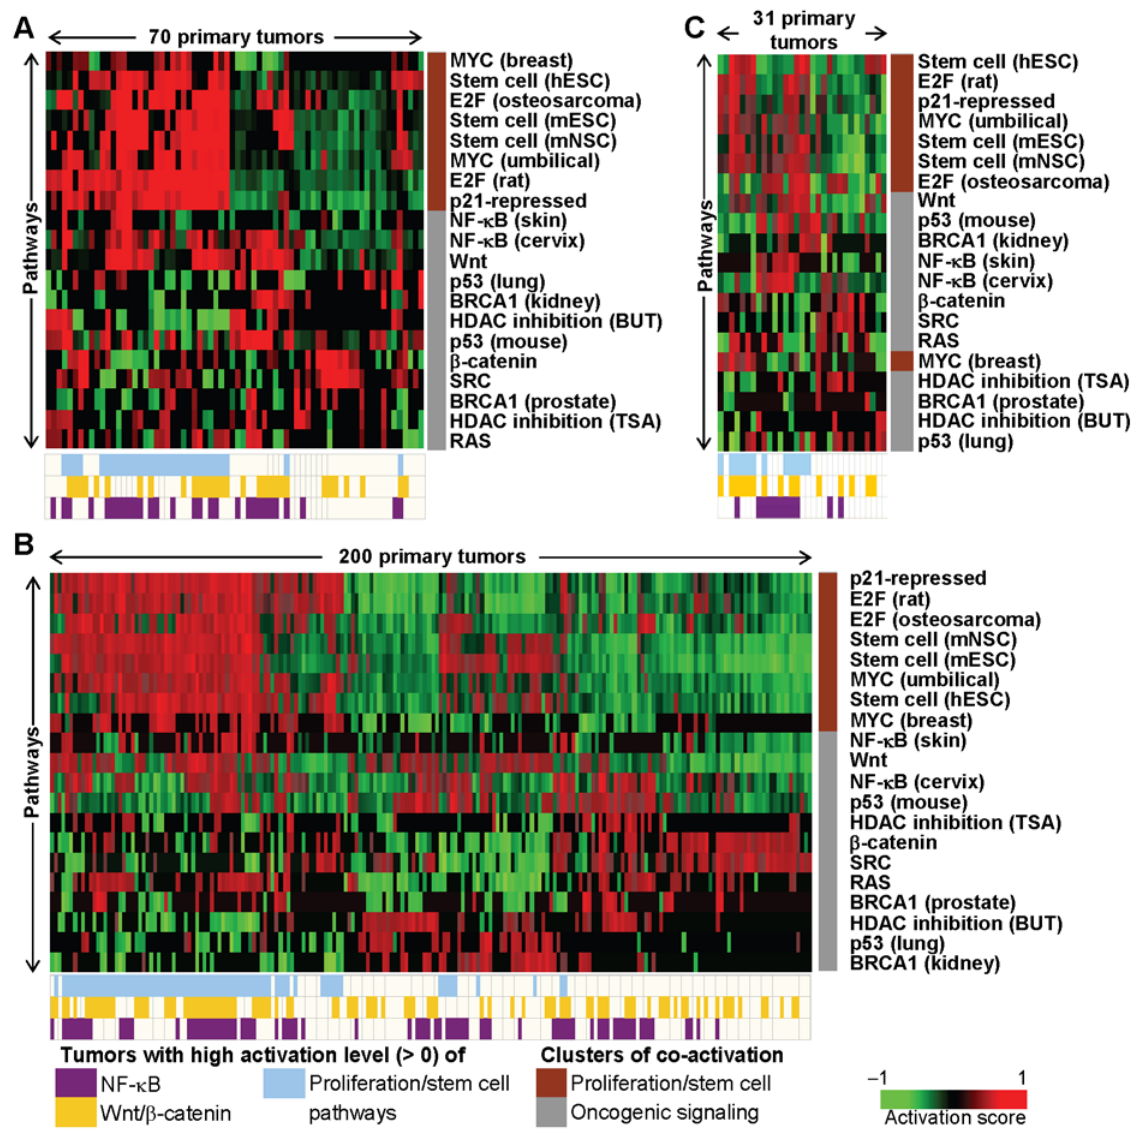
Figure 2. Patterns of pathway activation in primary gastric cancers. Twenty gene expression signatures representing 11 cancer-related pathways (MYC, p21-repression, E2F, NF- k B, RAS, Wnt/ b -catenin, SRC, BRCA1, p53, HDAC inhibition, stem cell) were queried against 301 primary gastric cancer gene expression profiles from three independent patient cohorts—(A) Australia, (B) Singapore, and (C) United Kingdom. Each heatmap depicts the activation scores of pathways represented by the signatures (rows) in individual tumors (columns), with red squares denoting higher activation scores. Both pathways and primary tumors were ordered using unsupervised hierarchical clustering. Pathways related to proliferation or stem cell form a distinct cluster (brown) from other pathways (grey). Tumors with high predicted activation of NF- k B (purple), Wnt/ b -catenin (yellow), or proliferation/stem cell-related pathways (blue) are indicated by the relevant color bars at the bottom of the heatmaps. Individual signatures that represent similar pathways are differentiated by the wordings within brackets. E.g. Stem cell (hESC): human embryonic stem cell vs. Stem cell (mESC): mouse embryonic stem cell vs. Stem cell (mNSC): mouse neural stem cell; HDAC inhibition (TSA): trichostatin A vs. HDAC inhibition (BUT): butyrate.